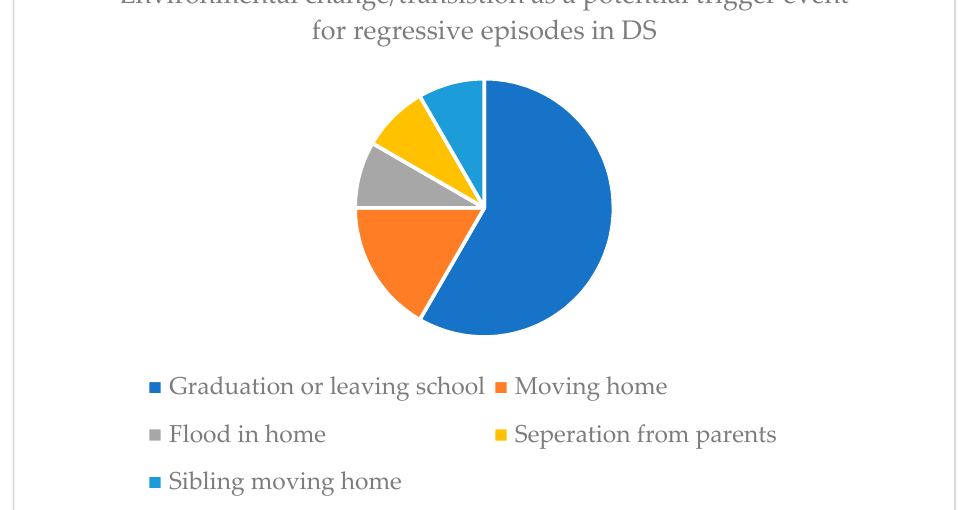
Figure 5. Breakdown of the environmental or transitional event circumstances that may have preceded a regressive episode ( n = 12).